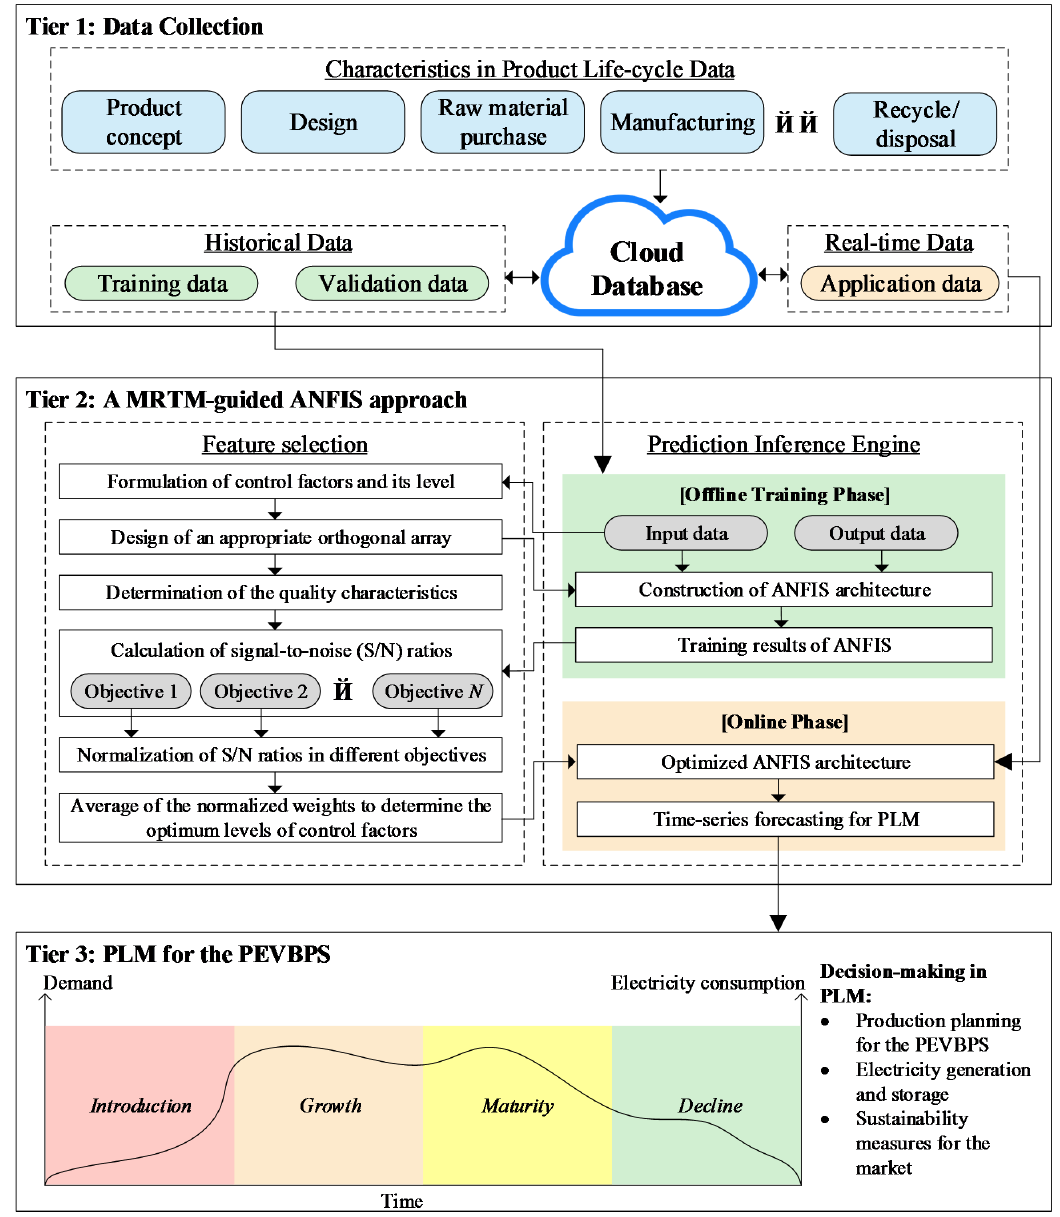
Figure 2. The modular framework of the fuzzy-based battery life-cycle prediction framework (FBLPF). MRTM denotes multi-response Taguchi method; ANFIS denotes adaptive neuro-fuzzy inference system; PLM denote product lifecycle management.